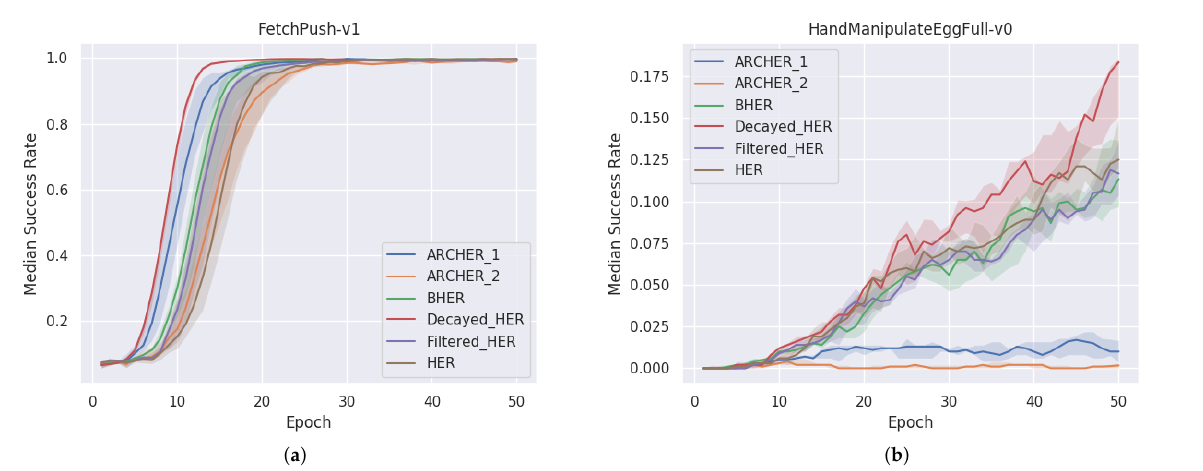
Figure 4. Learning curves for bias-reduced HER variants on ( a ) Pushing, ( b ) ManipulateEgg. The bold line shows the median test success rate over 6 random seeds and the shaded areas represent the 25th to 75th percentile. For ARCHER, we plot the best and averaged results with two different aggressive amplify factors. Our method achieves the best average performance both on sample efficiency and final median success